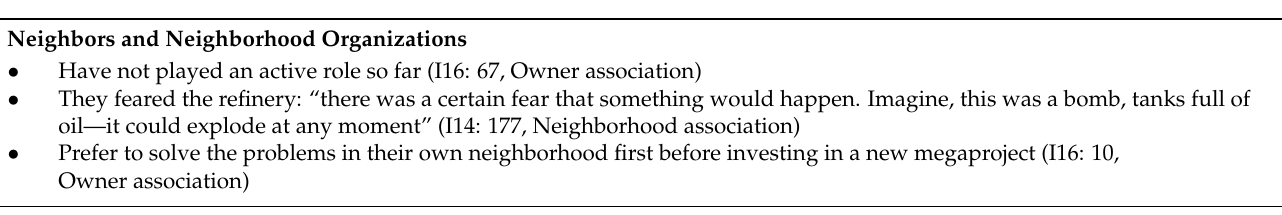
Table 5. Peripheral